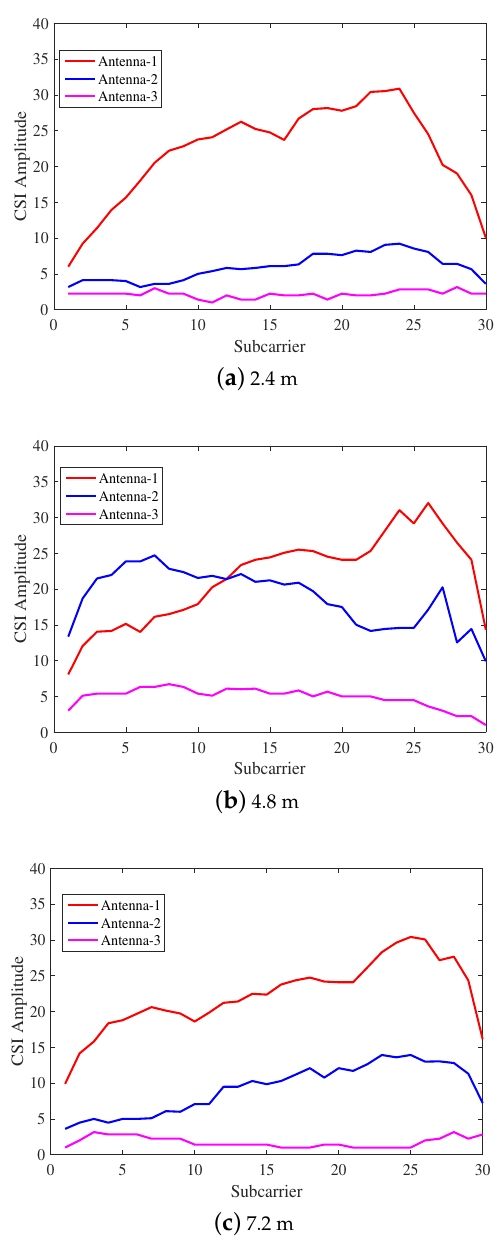
Figure 2. The channel status information (CSI) amplitude changes under different distances of the indoor open